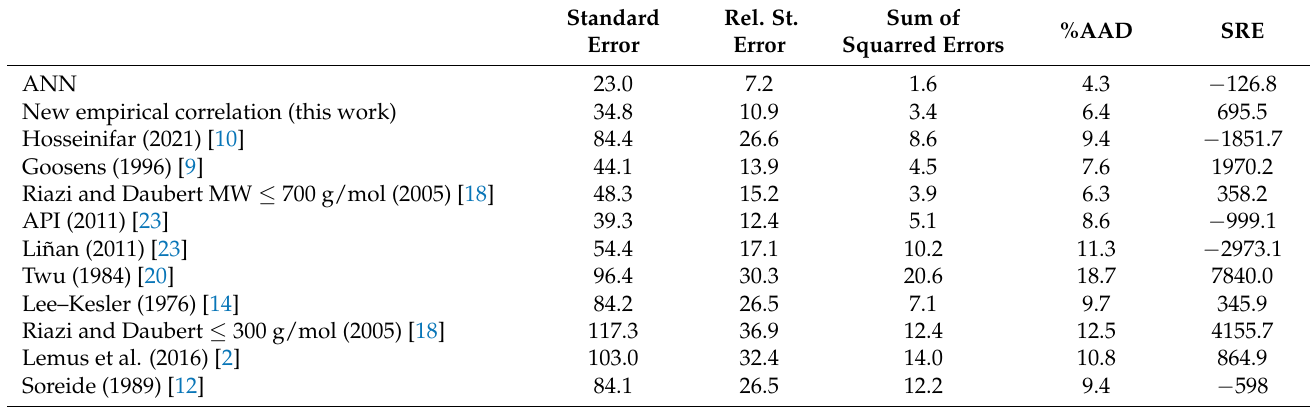
Figure 9. Parity graph for predicted versus measured molecular weight by Equation (11) (Liñan et al.) ( a ) and by Equation (13) (Hosseinifar, and Shahverdi) ( b ). Table 2 summarizes the statistical analyses for the new empirical correlation, the ANN model, and the ten studied empirical correlations available from the literature. Table 2. Statistical analysis of studied methods to predict petroleum fluid molecular weight for the whole range of studied molecular weights.